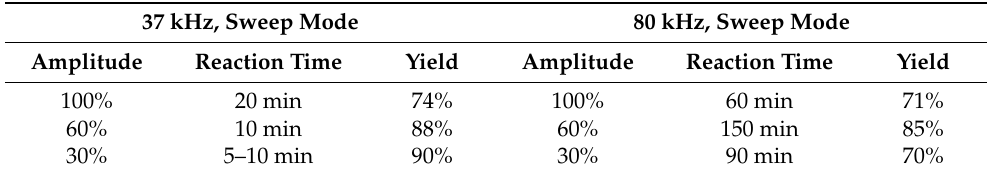
Table 2. Reaction of coumarin 4 with zinc and (ClCH 2 CO) 2 O in different frequencies and amplitudes. 37 kHz, Sweep Mode 80 kHz, Sweep